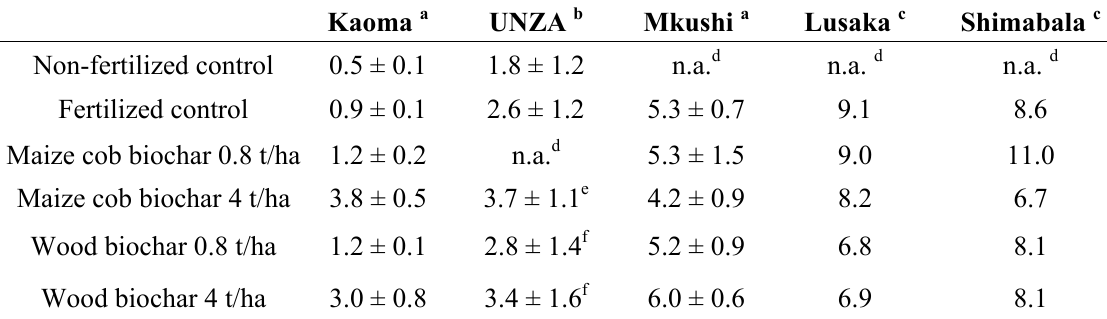
Table 2. Maize grain yields (tons/ha) for the five sites, without biochar and without fertilizer (“non-fertilized control”), without biochar but fertilized (“fertilized control”), and fertilized plus biochar-amended. Individual numbers for seasons 2011 and 2012 for Kaoma and Mkushi can be found in Table S1. Standard deviations are given either for two cropping seasons (Kaoma and Mkushi) or for four replicate blocks (UNZA), as indicated. For Lusaka and Shimabala, no replication was done.